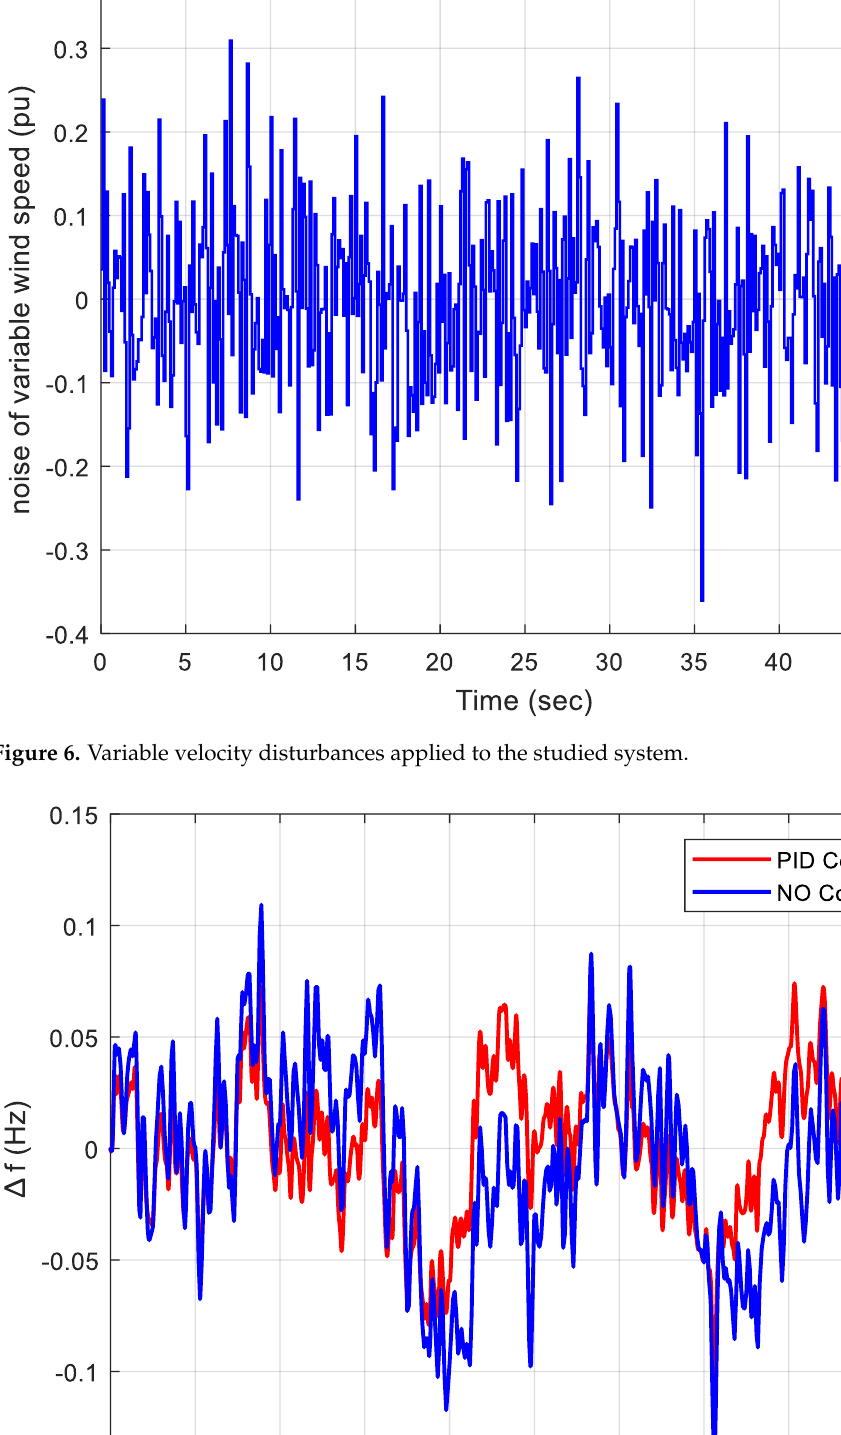
Figure 8. Frequency changes with PSO and PSO-GSA.